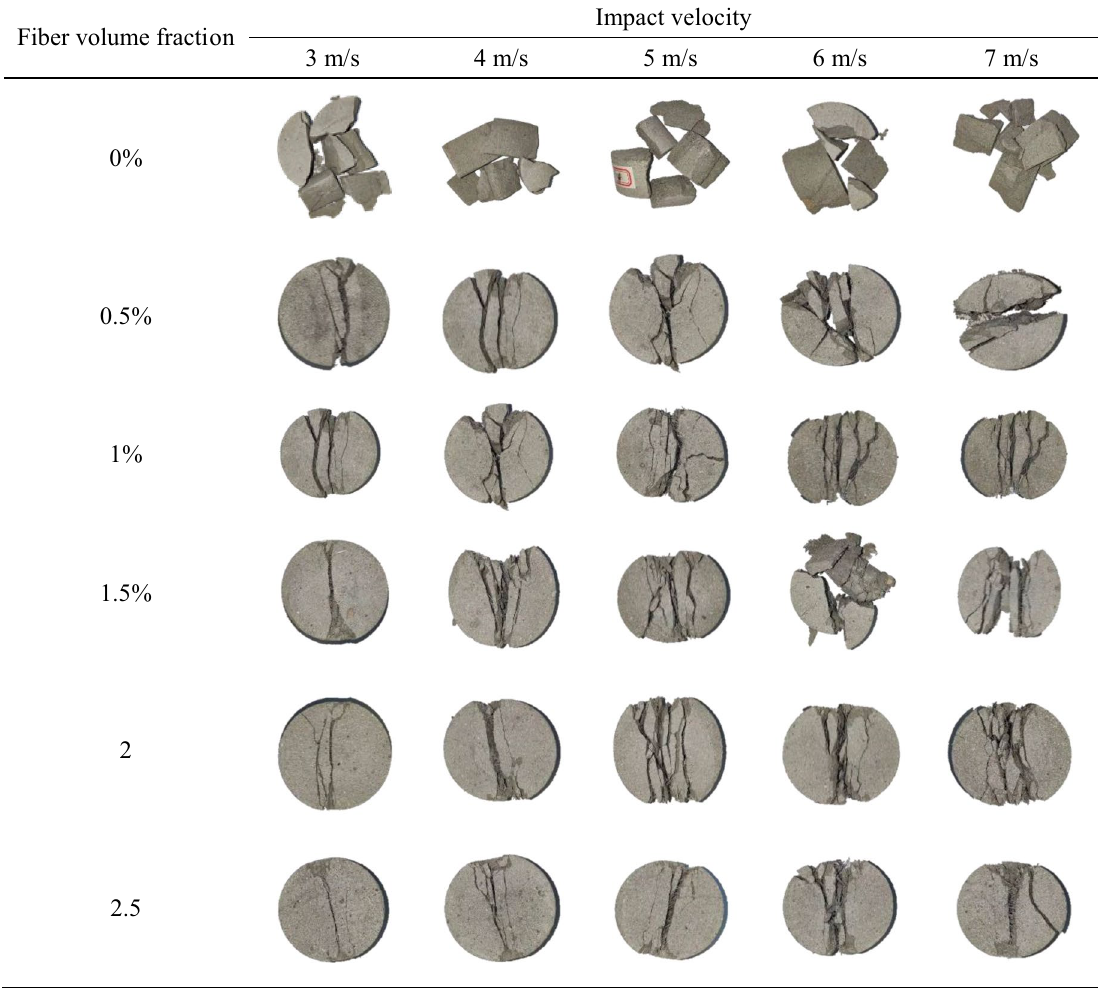
Table 3 Failure modes of macro-PPFRCCs Fiber volume